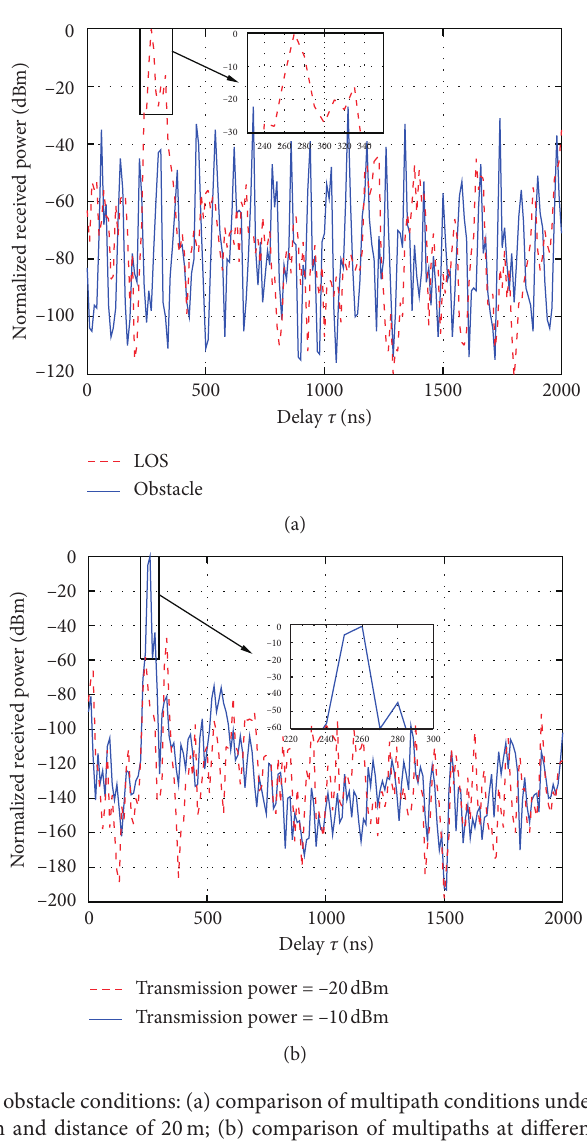
Figure 7: Comparison of PDPs with obstacle conditions: (a) comparison of multipath conditions under LOS and obstacle conditions with a fixed transmission power of 10 dBm and distance of 20m; (b) comparison of multipaths at different transmission powers.